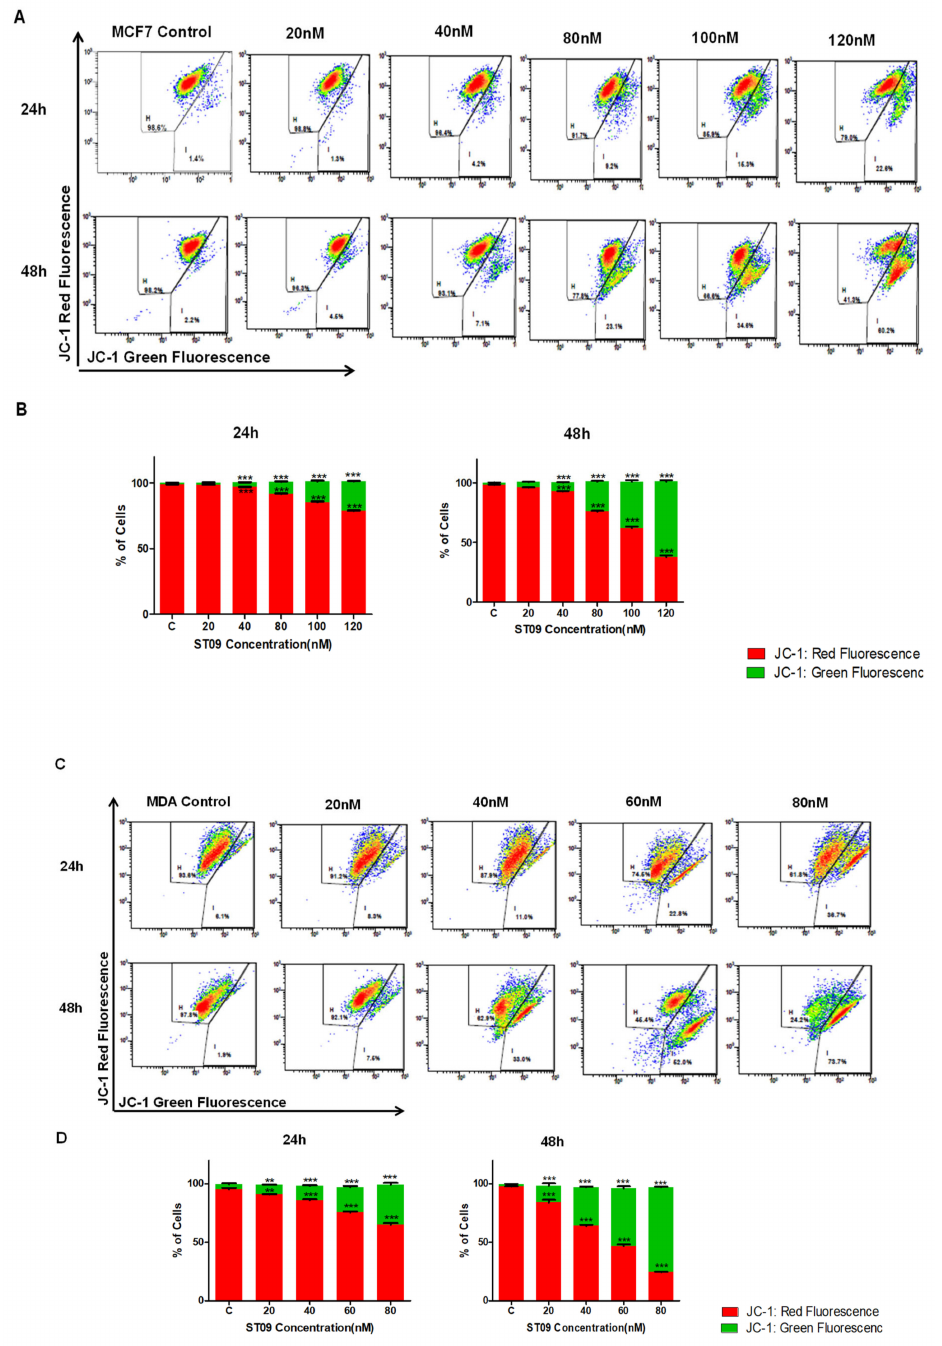
Figure 5. Evaluation of the mitochondrial membrane potential (MMP) changes induced by ST09 in breast cancer cells on JC-1 staining: dot plot depicting 24 and 48 h treated MCF7 ( A ) and MDA-MB-231 ( C ) cells by ST09 subjected to JC-1 staining. Quantification of high and low MMP is depicted as a bar graph after 24 and 48 h treatment of ST09 on MCF7 ( B ) and MDA-MB-231 ( D ) cells. Every experiment was repeated three times and represented as histograms. A two-way ANOVA test was performed, and the p -value was calculated between the control and ST09 treated groups (** p < 0.005, *** p <